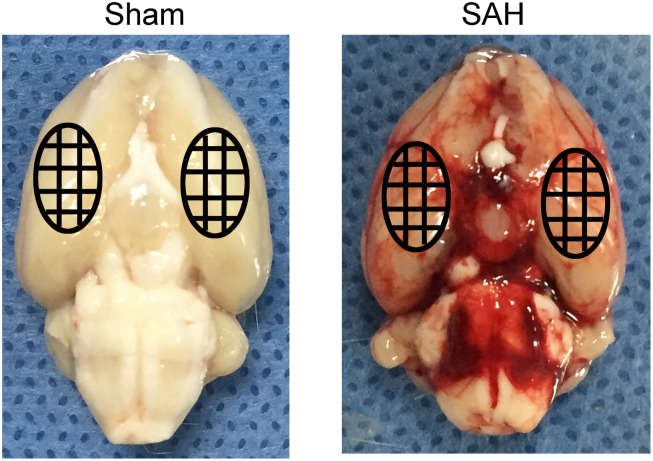
Representative images of whole brain from a Sham rat and a SAH model rat.